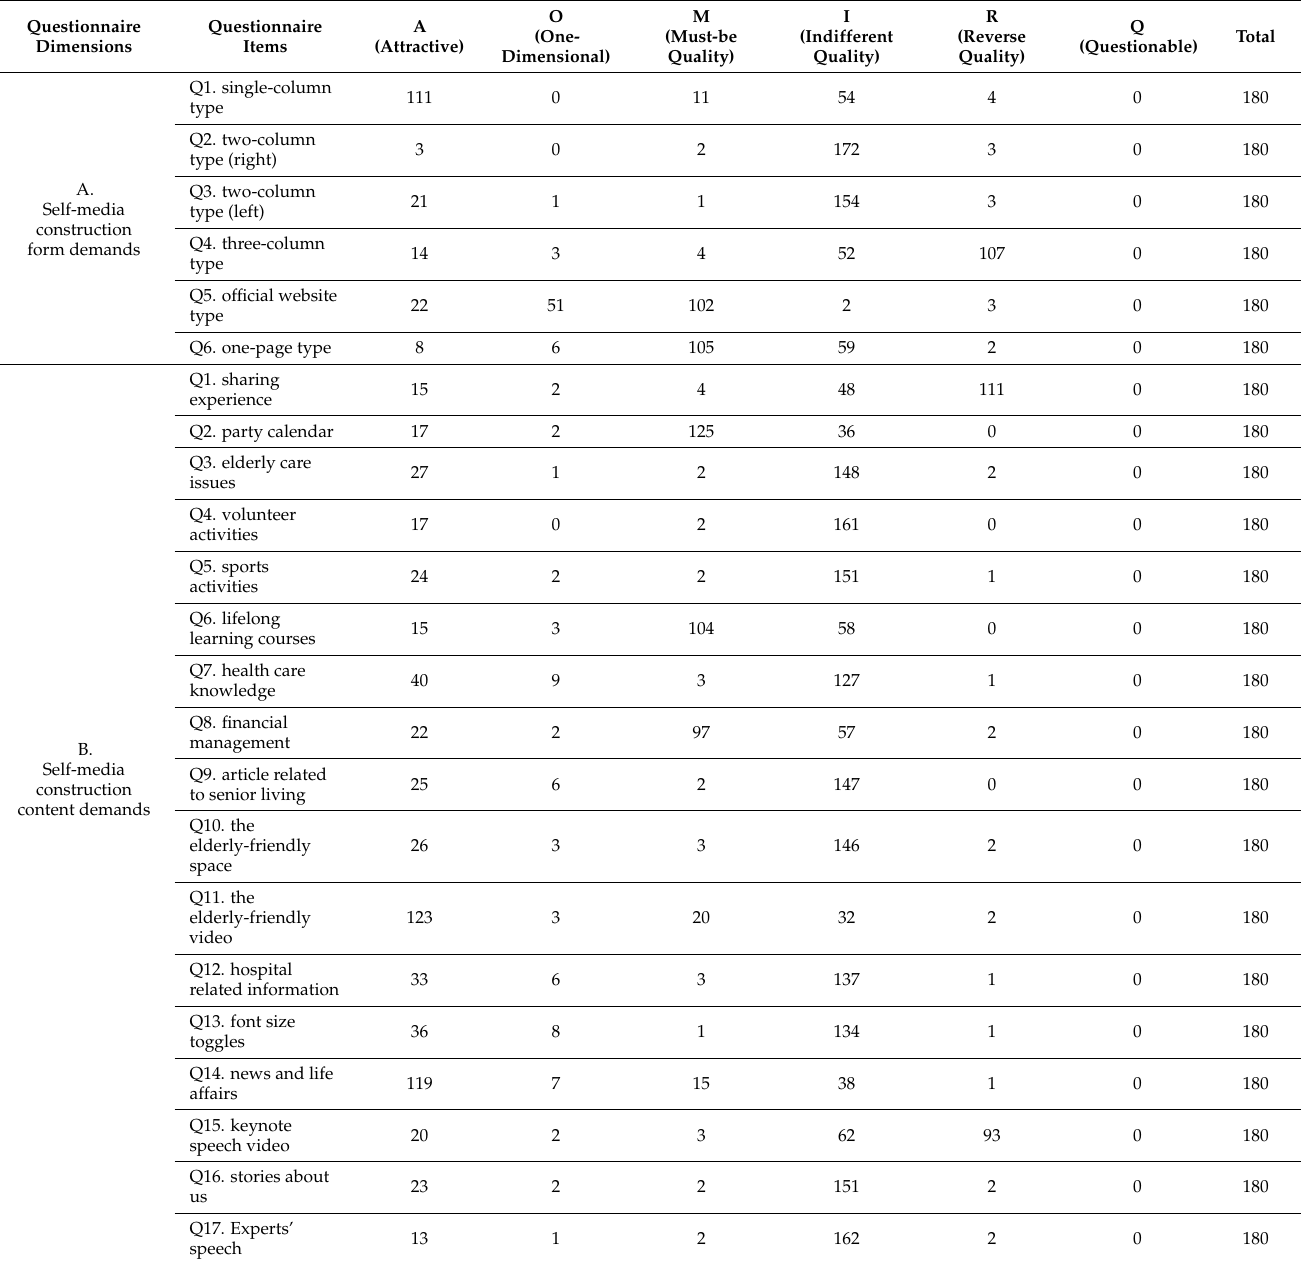
Table 3. The frequency distribution table of the Kano Model questionnaire for functional items ( N =